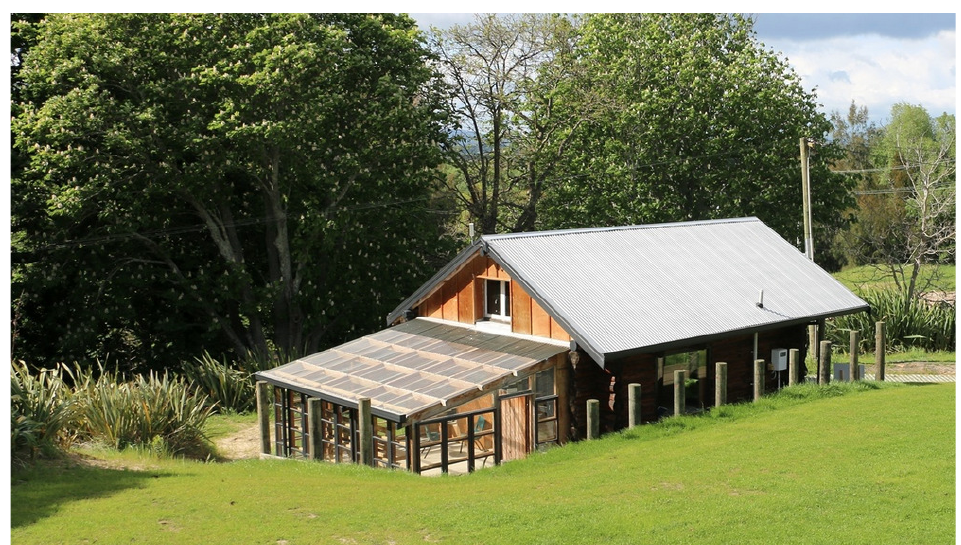
Figure 6. The LC after the